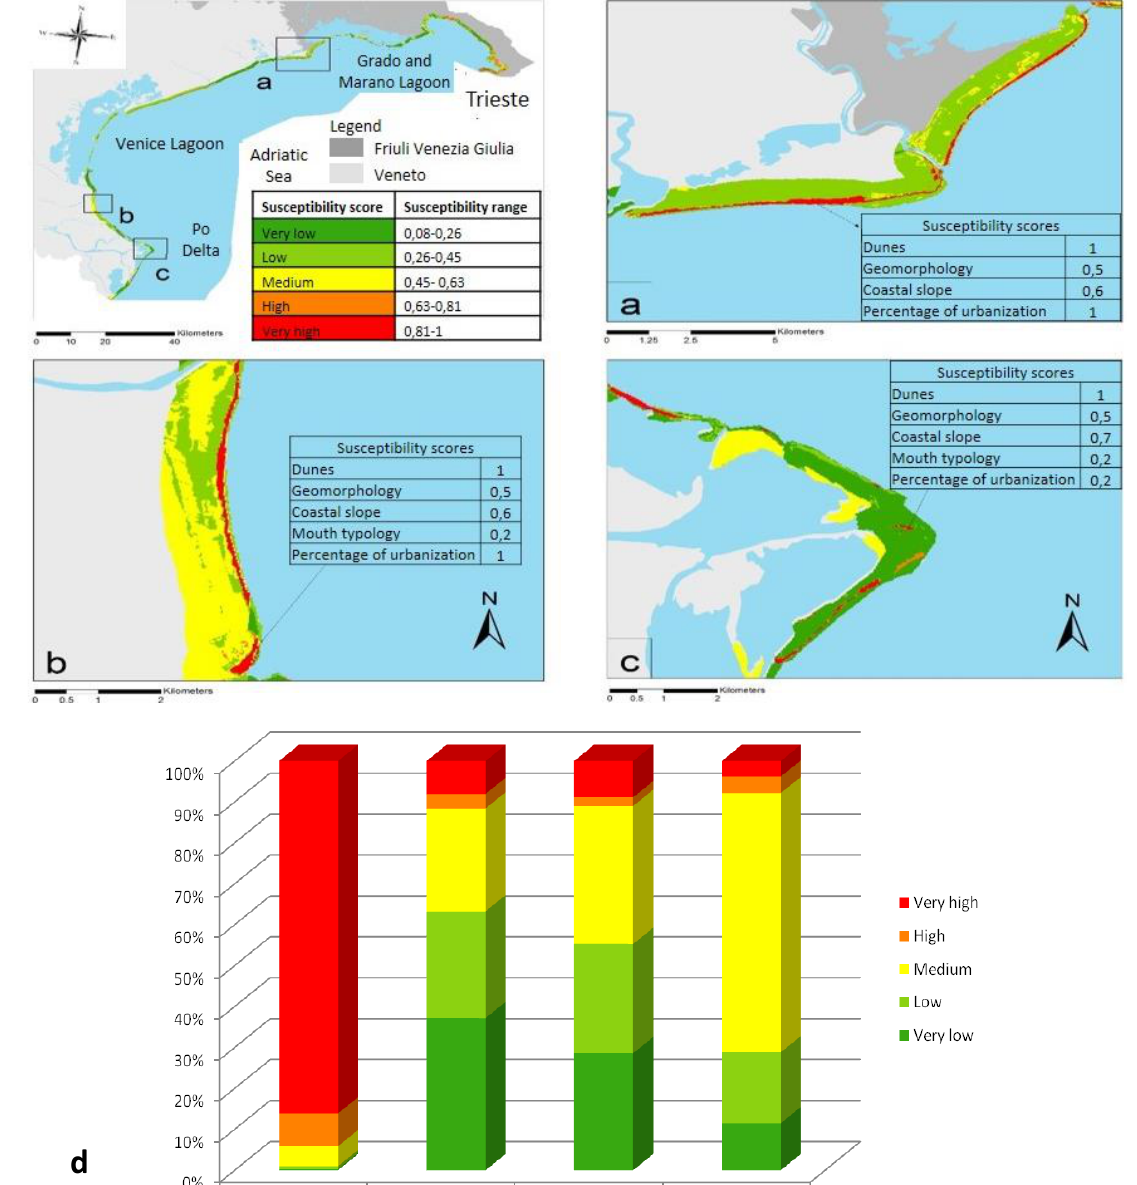
Figure 3. Susceptibility maps relative to three selected regions ( a – c ). The tables in the zooms sumarise the susceptibility factors responsible for the higher susceptibility score in the analyzed area; and distribution of the percentage of surface ( d ) associated with each susceptibility class for the each receptor located in the RICE area.